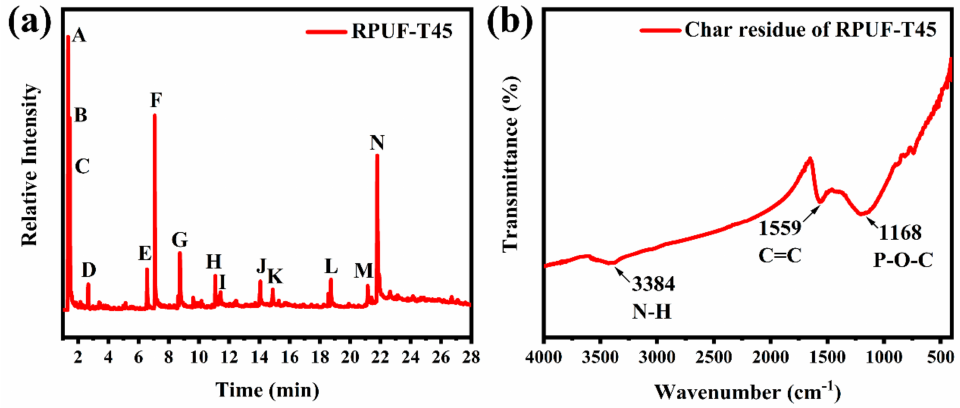
Figure 12. Pyrogram of RPUF–T45 at 650 ◦ C ( a ) and FT–IR spectrum of char residue of RPUF–T45 ( b ). The results of the pyrogram of RPUF–T45 and the FT–IR spectrum of the char residue of RPUF–T45 demonstrated that TBPBP acted as a flame retardant and played a role in both condensed and gas phases during